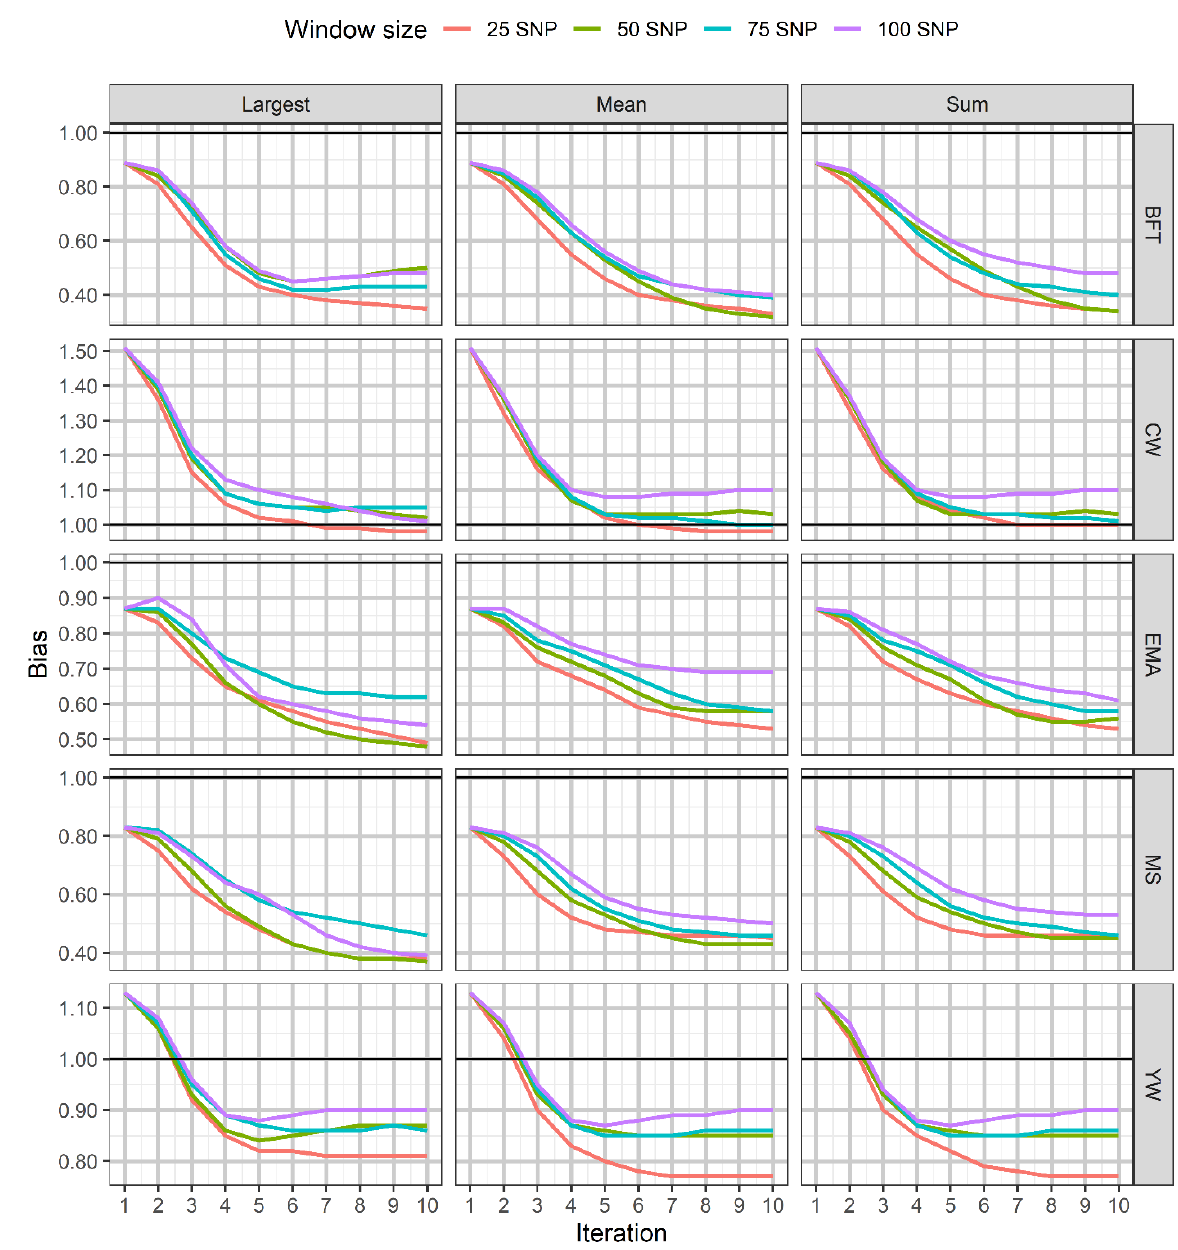
Figure 3. The trend in the bias of GEBV obtained using window weighting strategies with varying window sizes across iterations for the studied traits. BFT, backfat thickness; CW, carcass weight; EMA, eye muscle area; MS, marbling score; YW, yearling weight.